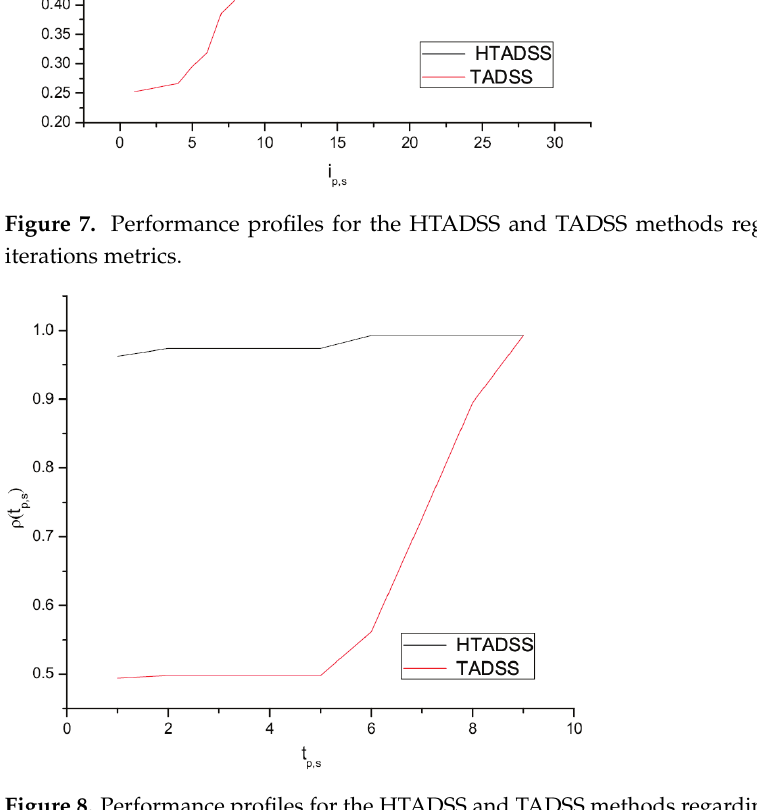
Figure 8. Performance profiles for the HTADSS and TADSS methods regarding the CPU time metric.